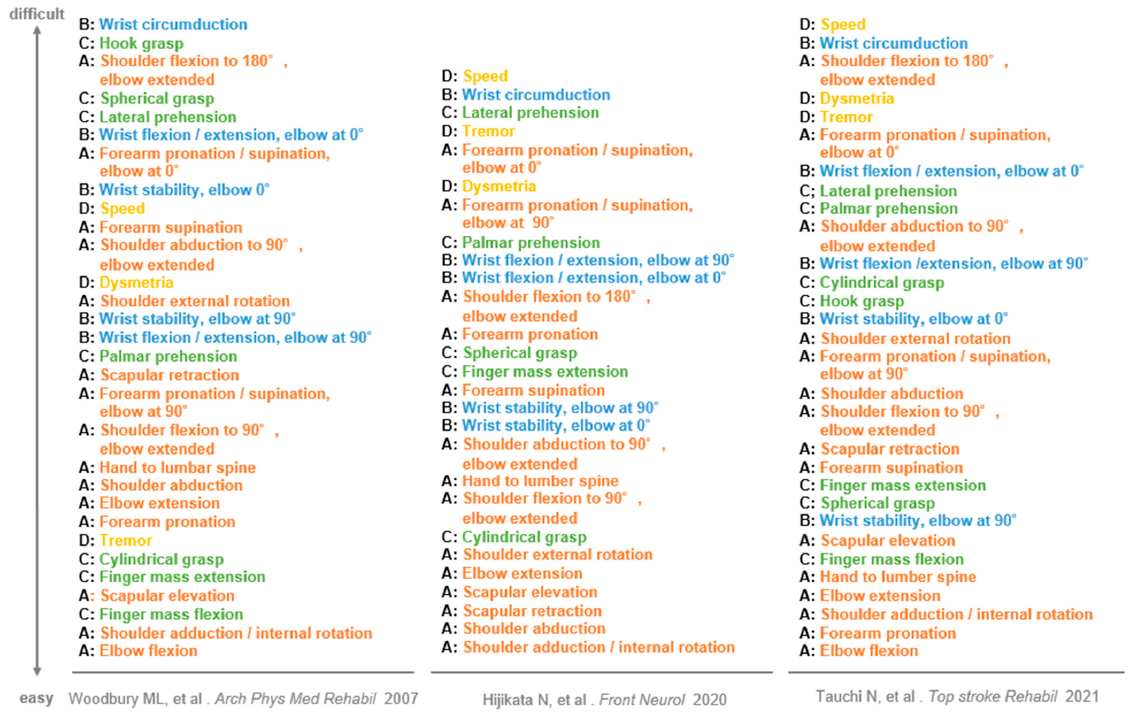
Figure 3. Item difficulty of Fugl-Meyer assessment for upper extremity. The results of three studies examining the difficulty of FMA-UE sub-items are presented. The sub-items with higher difficulty are located toward the top. A, B, C, and D next to the lower-level items indicate the corresponding subsection. As for the participants’ characteristics, Woodbury ML et al. reported that the participants were mainly patients with acute mild hemiplegia. Hijikata et al. reported that the participants were mainly patients with moderate-to-severe chronic-stage hemiplegia. Tauchi et al. reported that the participants were mainly patients with mild-to-moderate subacute-stage hemiplegia. This figure has been partly modified from the articles published by Woodbury, M.L., et al., 2007 [27], Hijikata, et al., 2020 [28], and Tauchi, et al., 2021